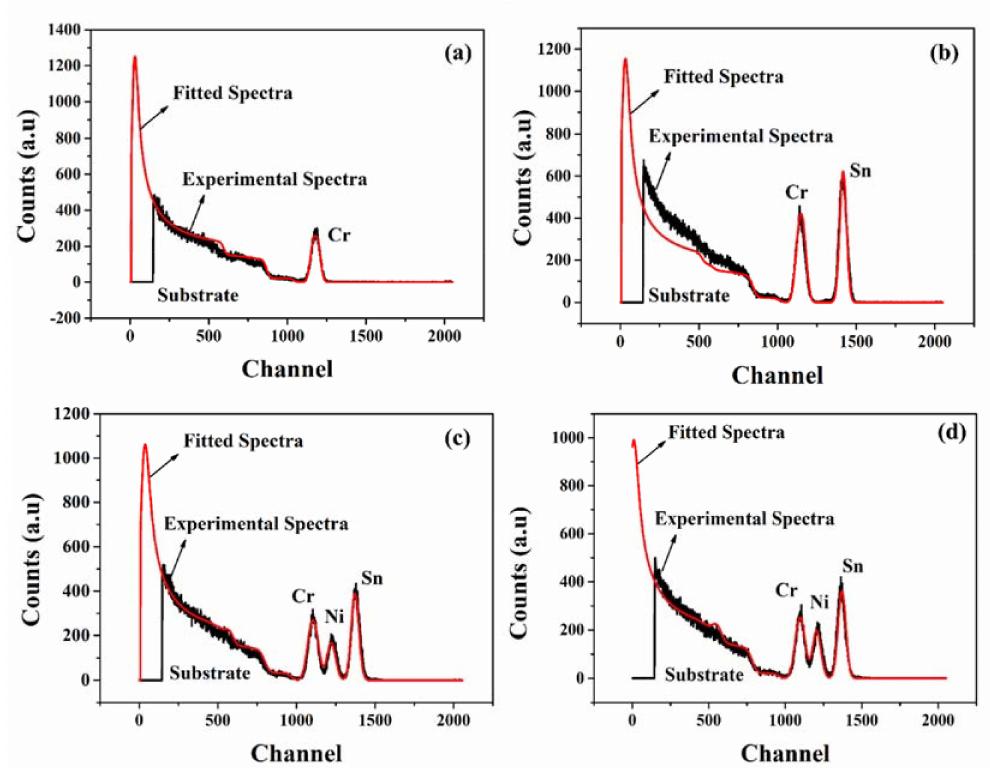
Figure 5. Experimental and fitted RBS spectra of ( a ) Cr, ( b ), Cr/SnO 2 , ( c ) Cr/SnO 2 /NiO, and ( d ) Cr/SnO 2 /NiO/Cr coatings,